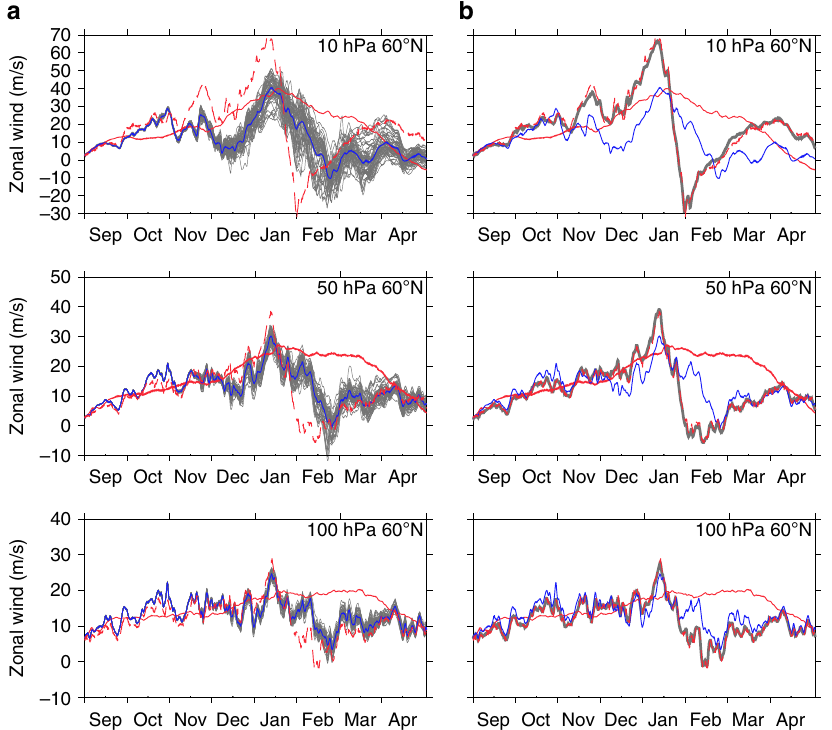
Fig. 2 Ensemble spread of the polar vortex evolution. Evolution of zonally averaged zonal winds (ms − 1 ) at 60 o N for all ensemble members at selected pressure levels from ( a ) the AllTrop experiment in which winds and temperatures from the surface to the tropopause at all latitudes were relaxed towards the European Centre Reanalysis Interim (ERA-Interim) data and b the AllTrop-UpStrat-Eq experiment in which the winds and temperatures from the surface to the tropopause were relaxed towards ERA-Interim data at all latitudes (as in the AllTrop experiment) and additionally the zonal winds in the upper equatorial stratosphere between 0 and 10 o N above 5 hPa were relaxed towards ERA-Interim data. Red dashed lines show the ERA-Interim data, and red solid lines show the evolution of the control run in which no relaxation was applied. Grey lines show individual ensemble members with a thick black line showing the ensemble mean. The AllTrop ensemble-mean is shown in blue in all plots for comparison. Note that the ensemble-mean of the AllTrop- UpStrat-Eq experiment that successfully reproduced the timing and vertical extent of the observed warming event is barely distinguishable from the observations (red dashed) and the individual ensemble members (grey) are barely evident because the ensemble spread is so